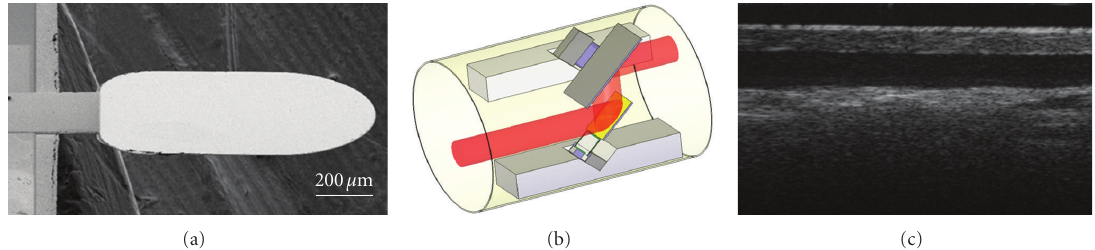
Figure 7: Piezoelectric MEMS OCT reported by Gilchrist et al. (a) SEM of MEMS mirror, (b) 3D MEMS probe design, (c) 2D image of IR card. Reprint permission granted by